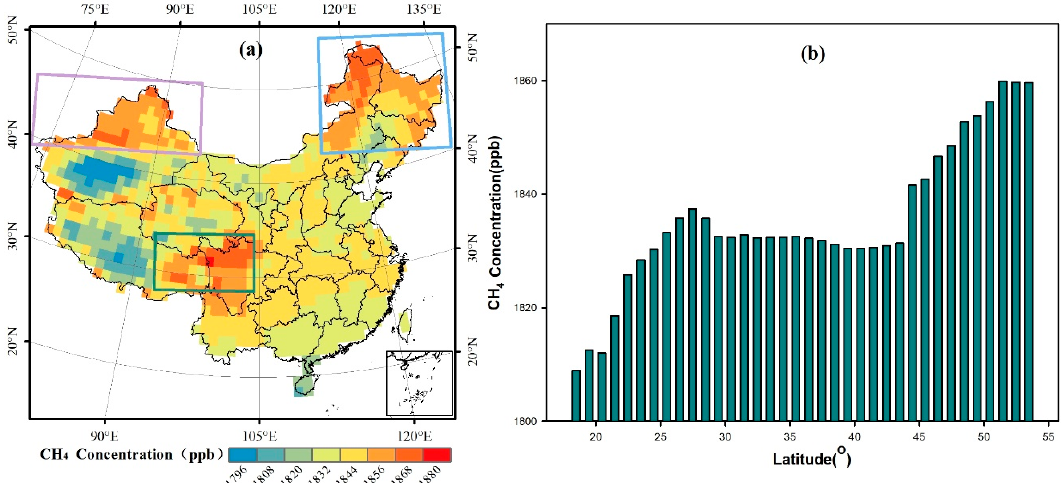
Figure 3. ( a ) The distribution of the averaged CH 4 concentration over the area of China from September 2002 to September 2016, derived from the AIRS products (the pink box represents Region I: northern Xinjiang; the blue box represents Region II: northeast of Inner Mongolia/Heilongjiang; the green box represents Region III: northwest Sichuan); ( b ) variations of CH 4 concentration distribution at over different latitudes, varying by one degree.